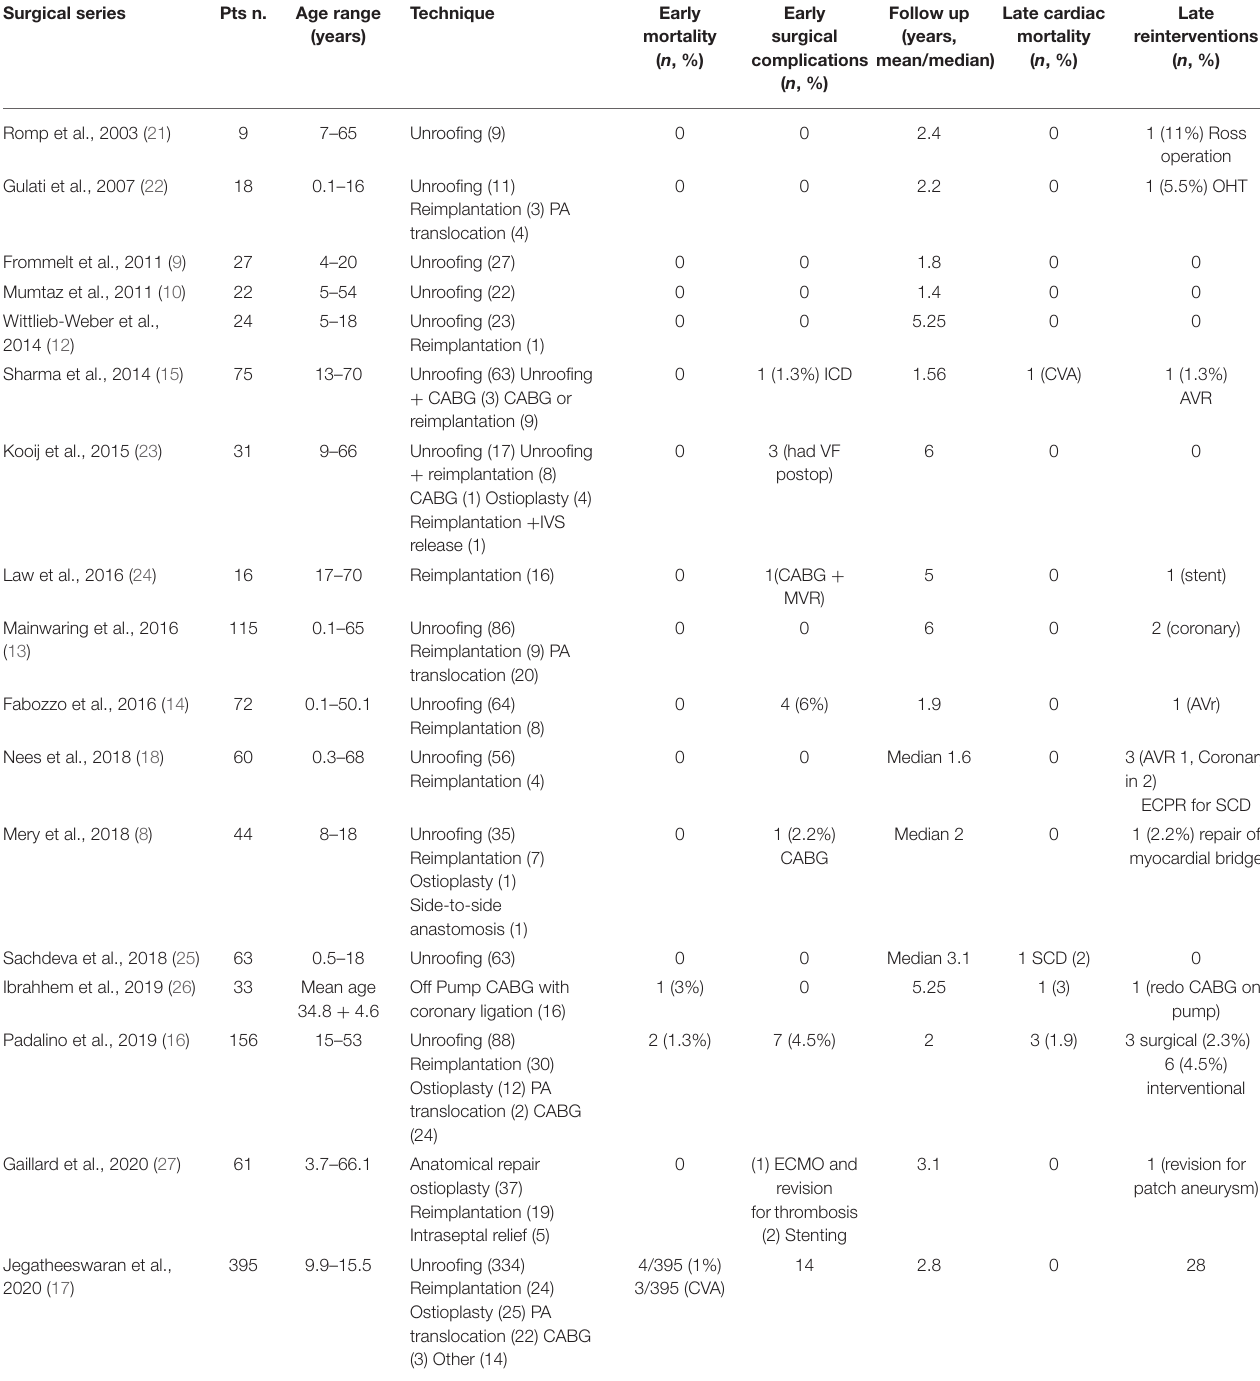
TABLE 1 | Surgical series reported in literature. Surgical series Pts